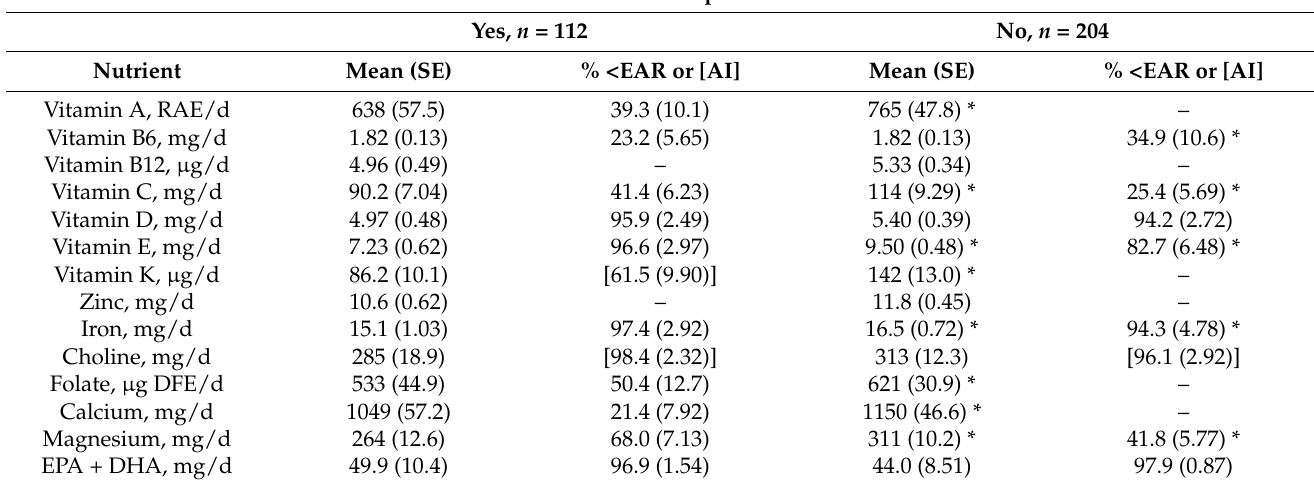
Table 6. Total usual intakes of nutrients important for neurodevelopment (foods alone) among pregnant non-lactating US women aged 20–44 y in the NHANES Survey by SNAP participation. Household Recipient of SNAP in Past 12